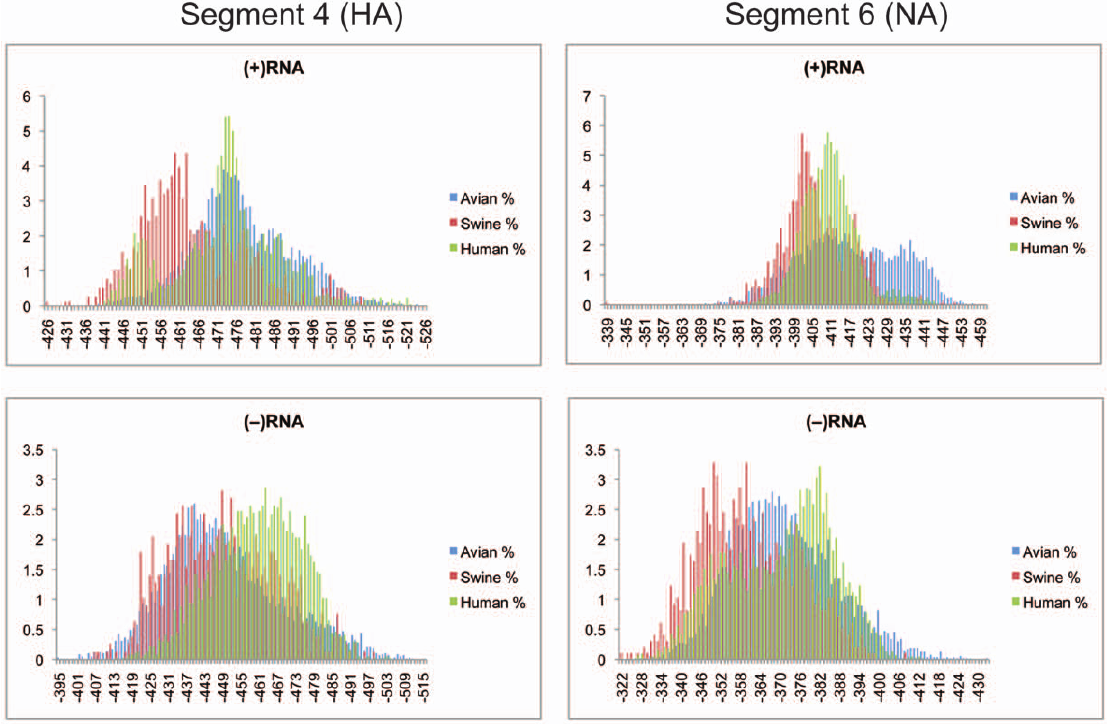
Figure 4. Predicted free energy distributions at 37 6 C for segments 4 and 6. ( + )RNA and ( 2 )RNA are shown in the top and bottom panels, respectively. See Figure 2 for annotations and details.